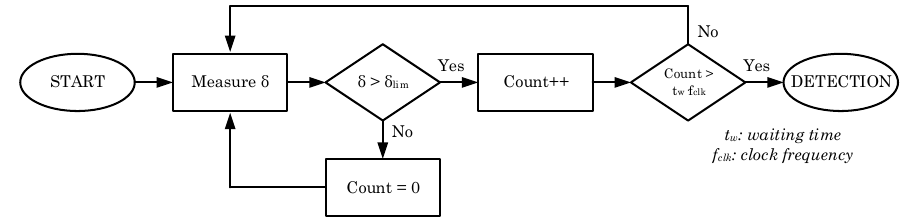
Figure 16. Islanding decision steps.